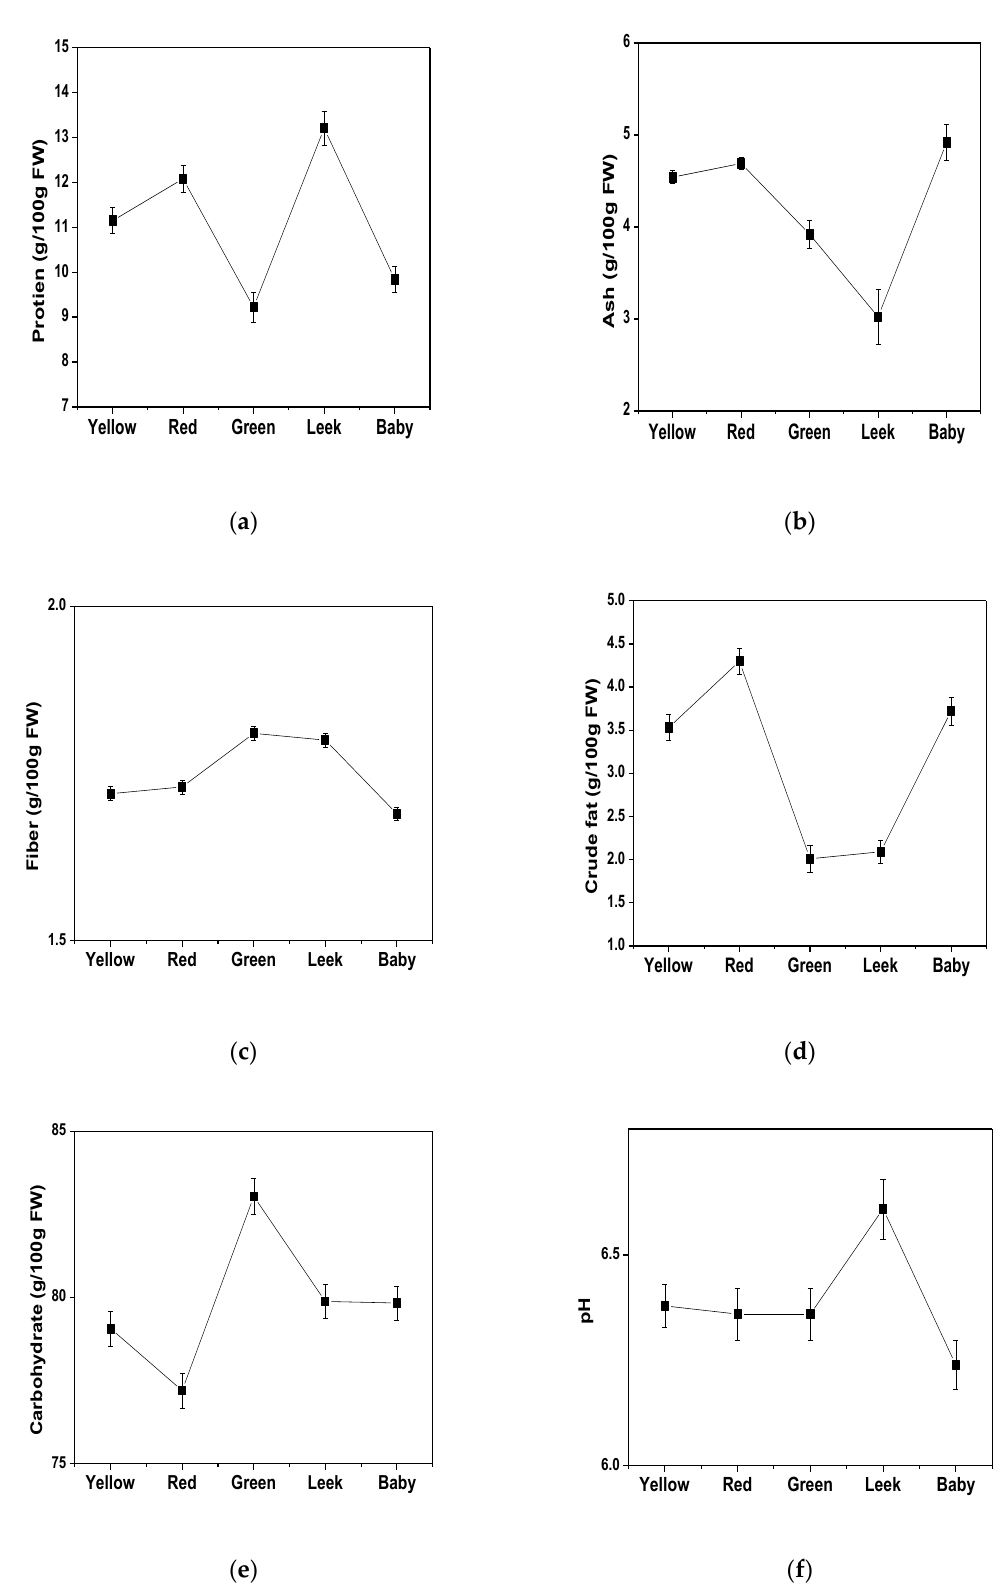
Figure 1. Nutritional values: protein ( a ), ash ( b ), fiber ( c ), crude fat ( d ), carbohydrate ( e ), and pH ( f ) contents of onion bulbs.